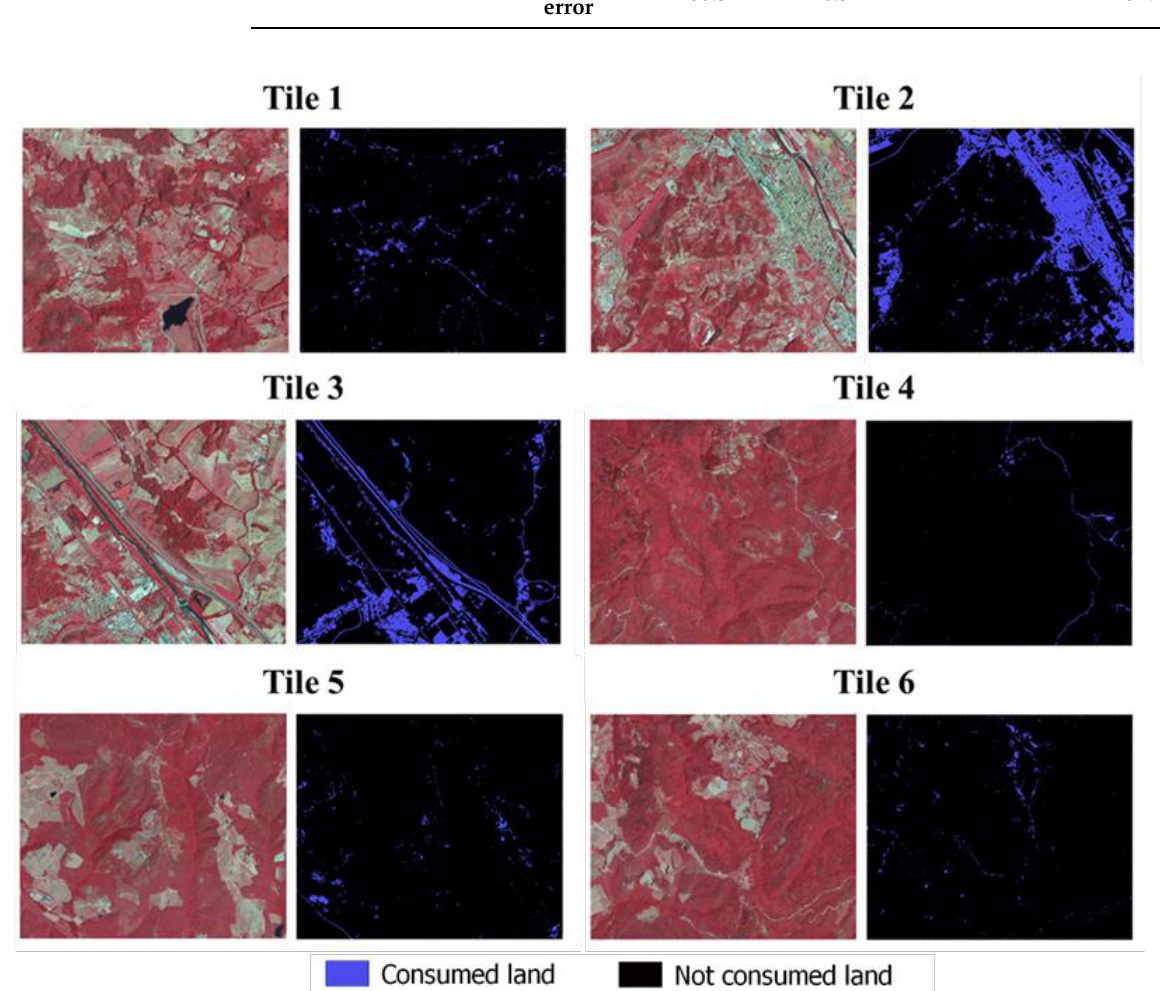
Figure 8. Classification results of the 6 study areas relating to B1 configuration.